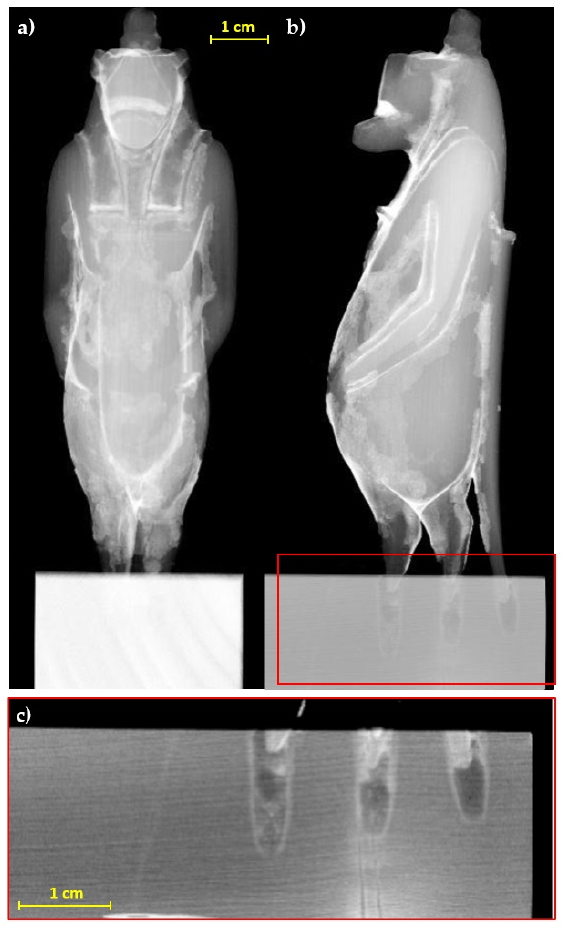
Figure 3. Radiographs of the statuette, ( a ) frontal and ( b ) lateral view; ( c ) detail of the legs and tail insertion in the modern base.